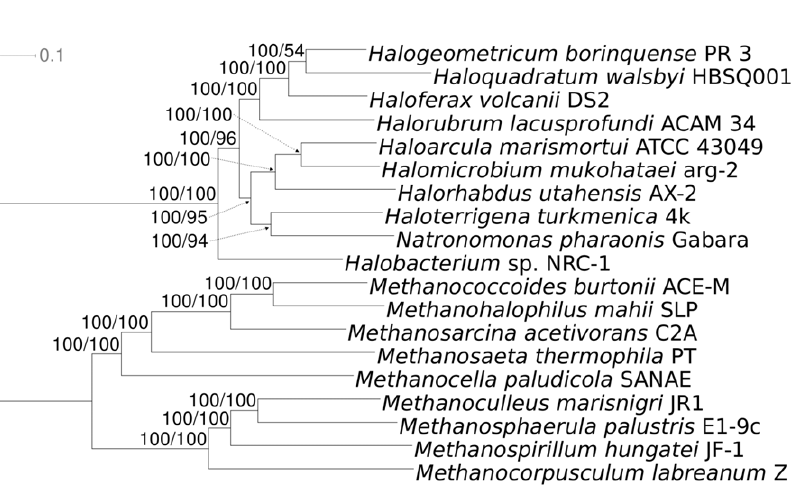
Figure 1. Maximum likelihood (ML) phylogenetic tree inferred from the 3,853-gene supermatrix. The branches are scaled in terms of the expected number of substitutions per site. Numbers above branches are support values from ML (left) and maximum parsimony (MP; right) bootstrapping. The tree was rooted with the Methanomicrobia genomes included in the sample. The topology of the single best MP tree was identical to the one depicted